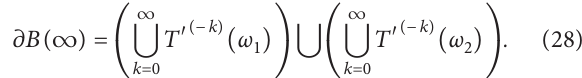
Figure 4: Schematic diagram of the critical curves, where the parameters are chosen as a � 7 . 212, b � 0 . 28, c � 1 . 1, α v � 0 . 4, and v � 0 . 1 2